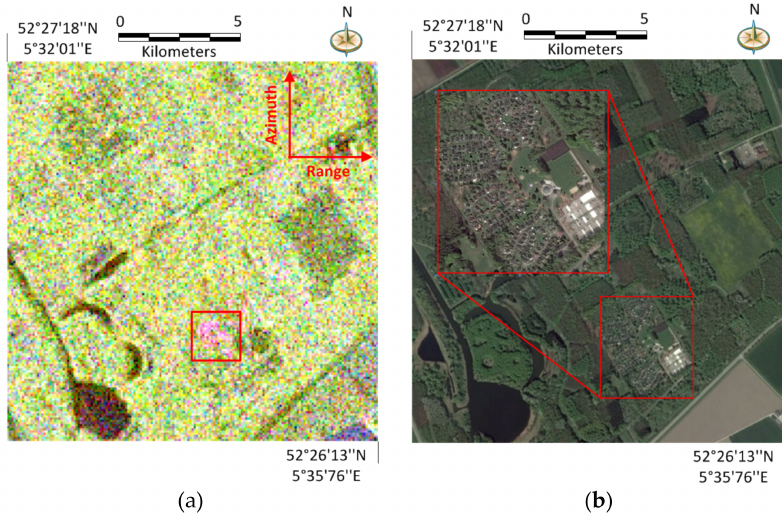
Figure 8. The study area and Radarsat-2 dataset. ( a ) Pauli-coded image with C-band (red: HH − VV, green: HV, blue: HH + VV); ( b ) Optical image from Google Earth, where the red area in the upper left image is the enlarged result of the lower right